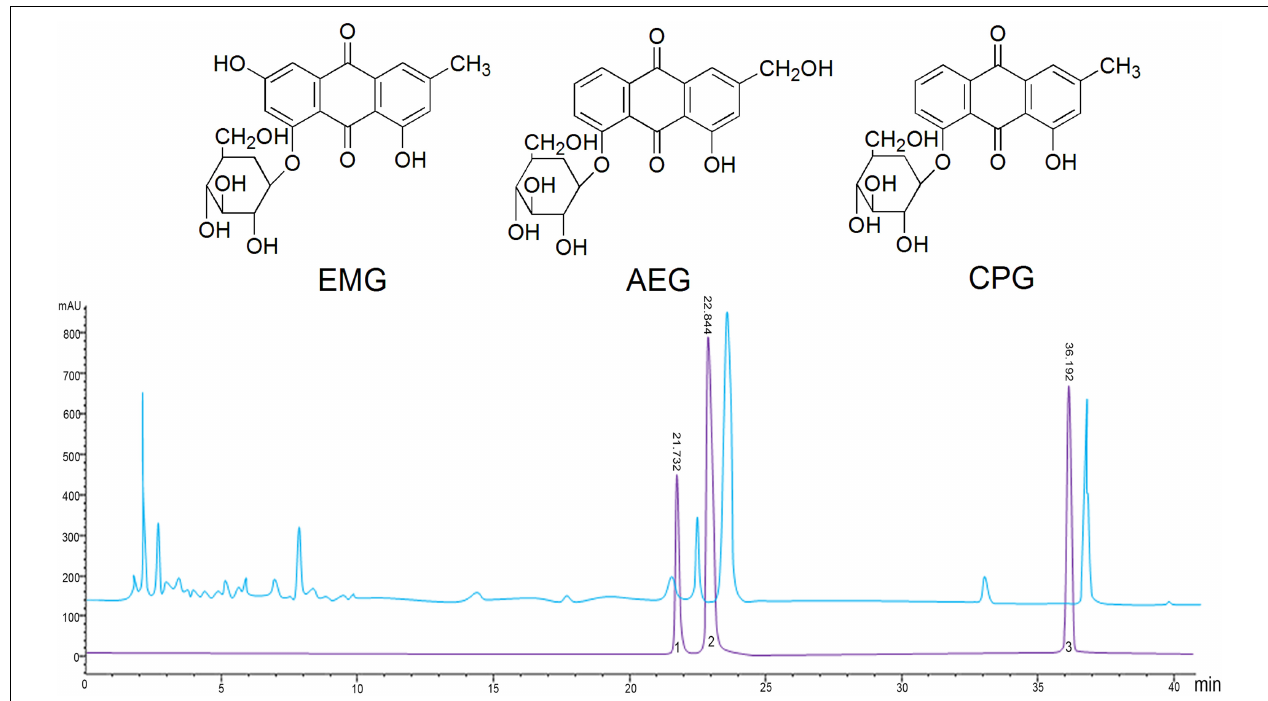
FIGURE 1 | The structure and HPLC chromatography of three anthraquinone glycosides in RAGP. 1: Emodin-8- O - β - D -glucoside (EMG), 2: Aloe-emodin-8- O - β - D -glucoside (AEG), 3: Chrysophanol-8- O - β - D -glucoside